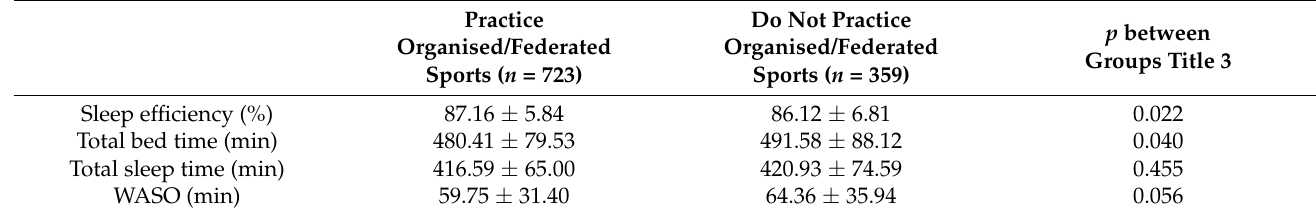
Table 2. Results of the daily sleep quality analysis.